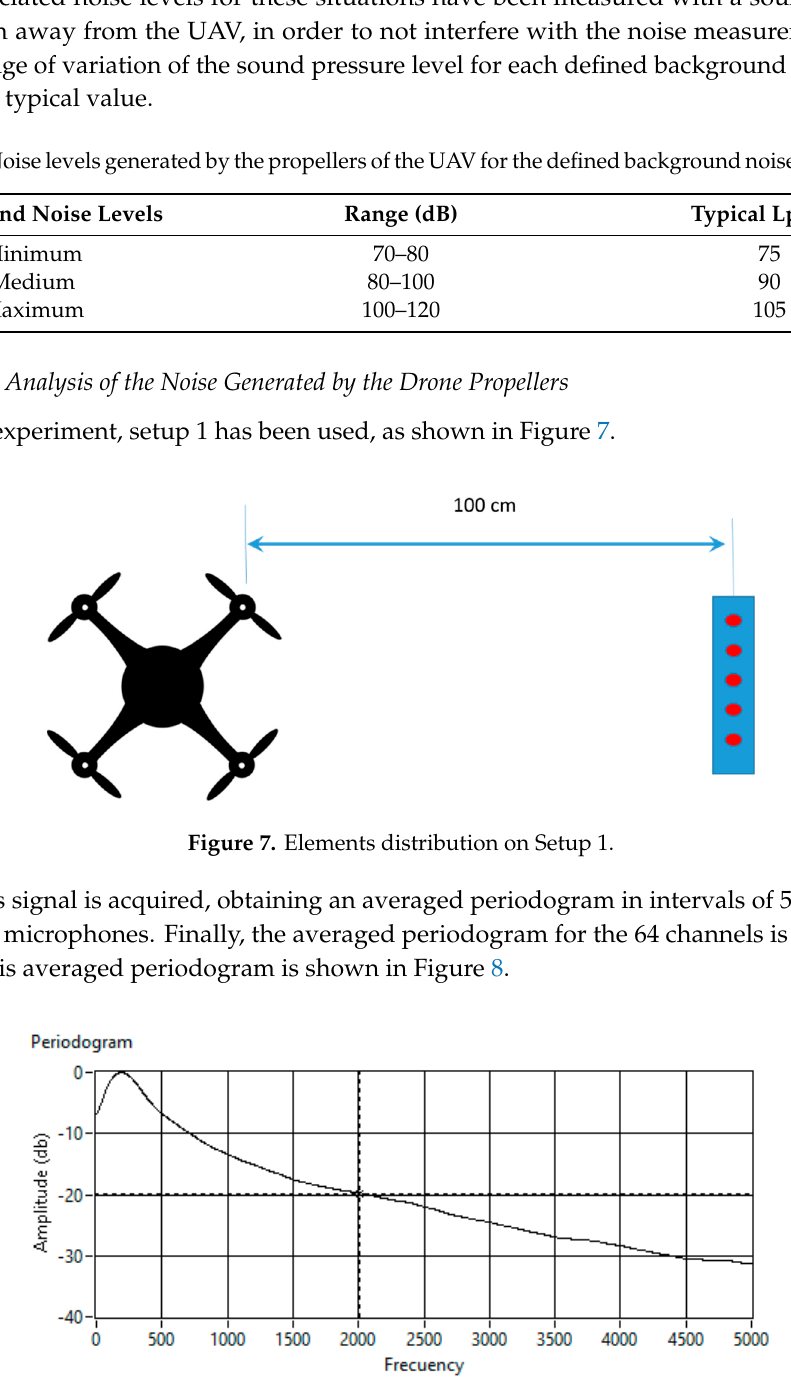
Figure 8. Averaged periodogram of the drone noise.